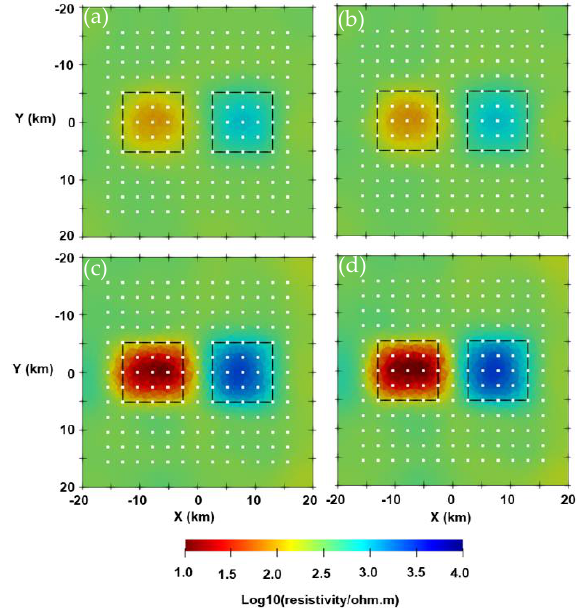
(f) Figure 16. Cont